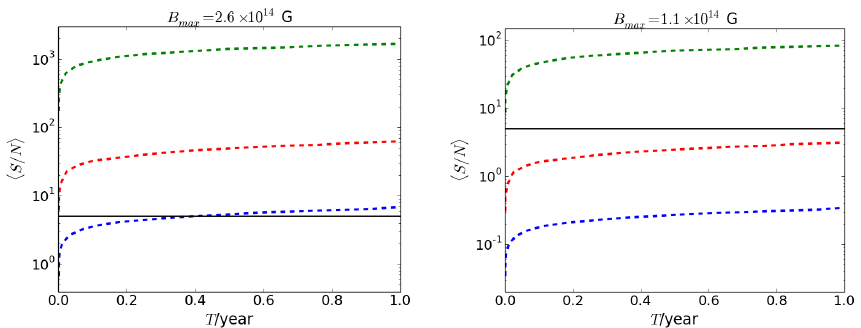
Figure 8. SNR as a function of integration time for a toroidal field-dominated WD with central density ρ c = 2 × 10 10 g cm − 3 , spin period P = 2s, χ = 30 ◦ and d = 100pc. The green (top) line represents ALIA , the red (middle) line represents TianQin and blue (bottom) line represents LISA . The solid black line corresponds to (cid:104) S / N (cid:105) ≈ 5. See [44].